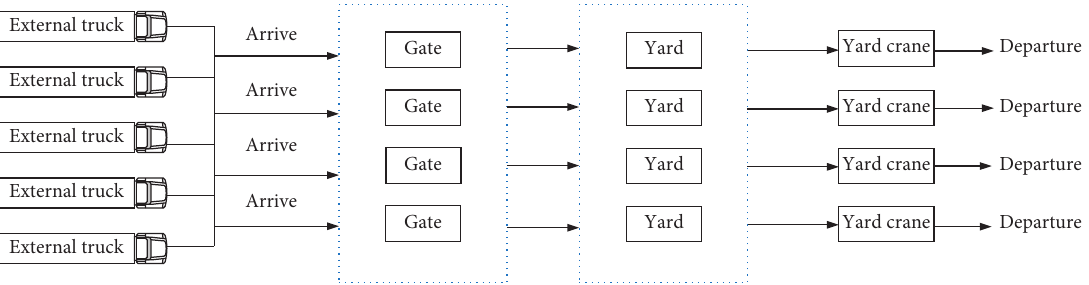
Figure 7: Operation process of external trucks. Table 1: Input variables and input values.